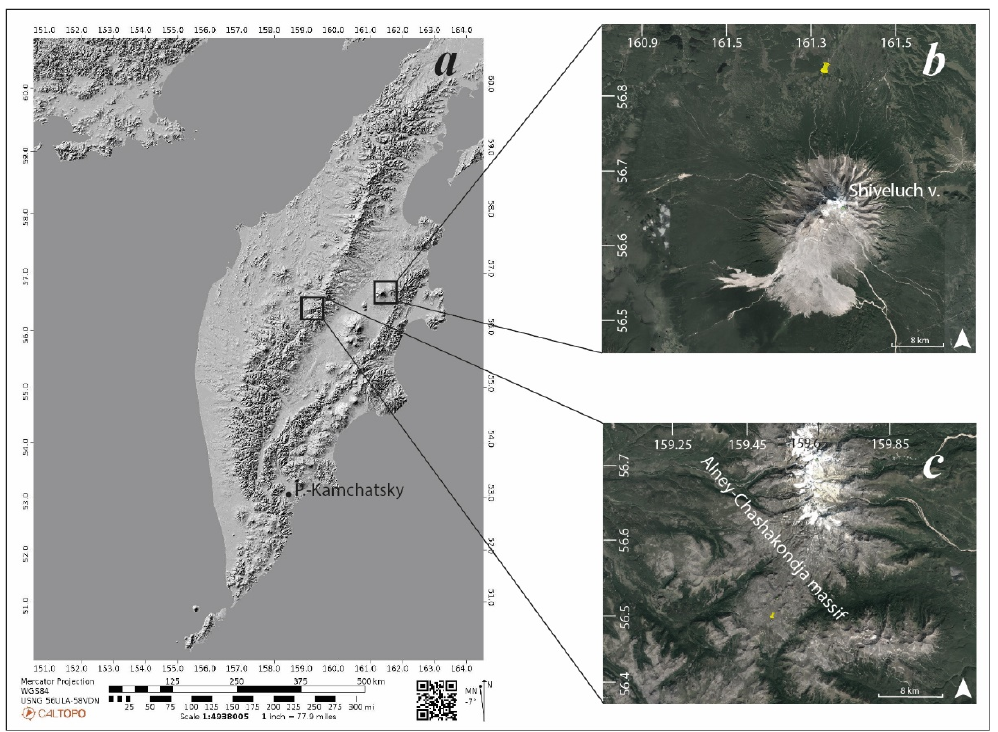
Figure 1. Geographic location of the soil sections: ( a )—map of the Kamchatka Peninsula; ( b )— Shiveluch volcano area; ( c )—Alney–Chashakonja massif. Caltopo DEM topographic base ( a ), Google Earth ( b , c ). The position of the sections under study is shown with yellow